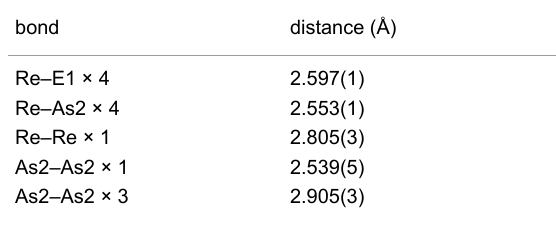
Table 3: Selected interatomic distances for S1 .